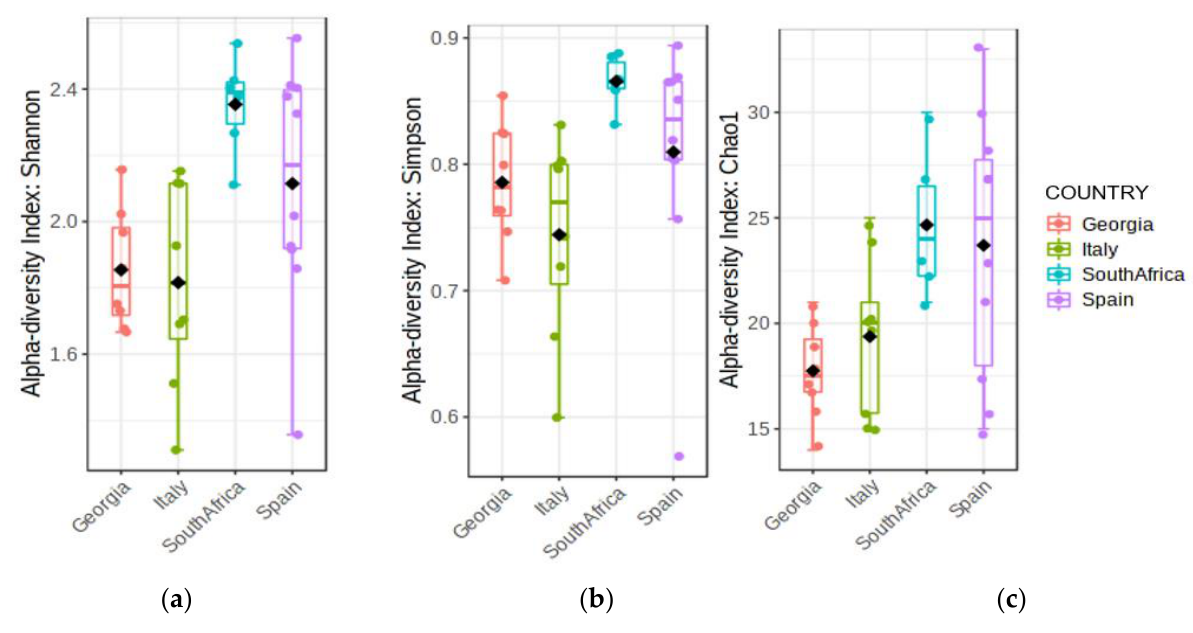
Figure 1. Analysis of the sample diversity: alpha-diversity index: ( a ) Shannon, p -value: 0.004172; (ANOVA) F-value: 5.5182; ( b ) Simpson, p -value: 0.02898; (ANOVA) F-value: 3.4793; ( c ) Chao, p -value: 0.012439; (ANOVA) F-value: 4.339. The colored solid line inside the box is the median value, and the black rhombus is the mean value; the colored dots are individual samples.